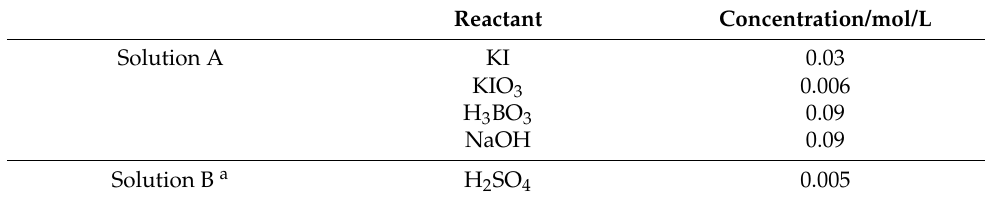
a The concentration of H 2 SO 4 in solution B was the concentration when the ratio of flow rates of two fluids was 1:1. When the ratio of flow rates of mixing fluids was R:1 (solution A over solution B), the concentration of H 2 SO